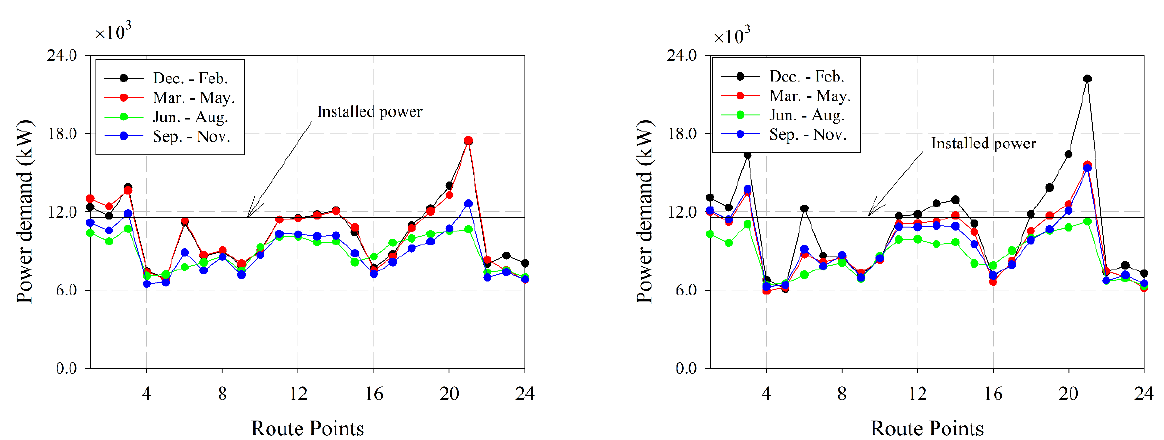
Figure 15. Power demand in each route point per load condition and per season. ( Left ) Load Condition 1. ( Right ) Load Condition 2. Source: Own elaboration.